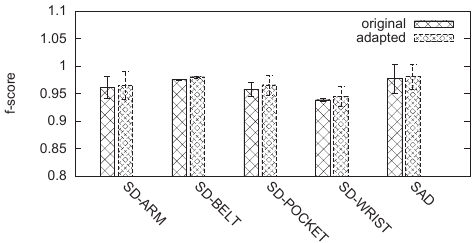
Figure 12: Performance(f-score) decrement with an inaccurate initial